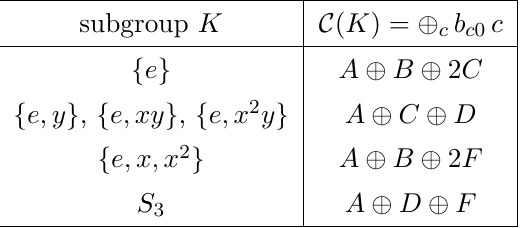
Table 1. Condensed anyons corresponding to boundary subgroup K